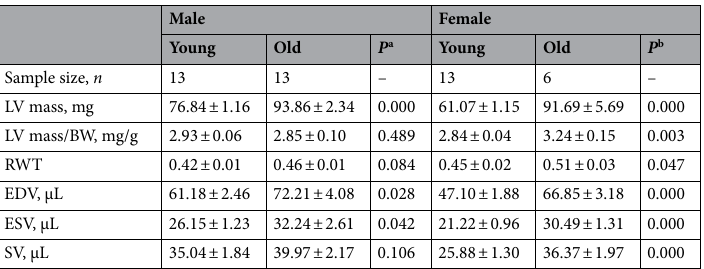
Table 2. Cardiac structural ECG parameters of the study population. a Between young and old males; b between young and old females. BW body weight; RWT relative wall thickness; EDV end-diastolic volume; ESV end-systolic volume; SV stroke volume.